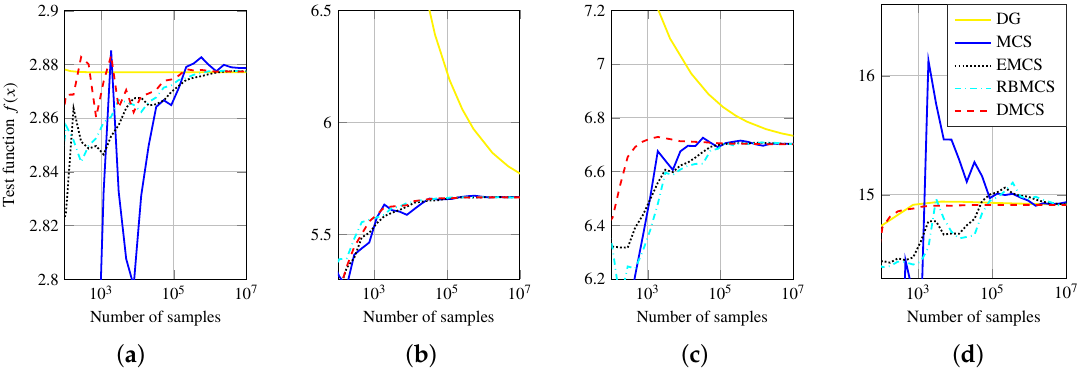
Figure 2. Convergence of the five sampling concepts using the test function f ( x ) and different input dimensions d and exponents m mat . For non-deterministic concepts, several runs were conducted and a “representative” one is shown here. ( a ) d = 1, m mat = 1; ( b ) d = 6, m mat = 1; ( c ) d = 6, m mat = 4; ( d ) d = 6, m mat =